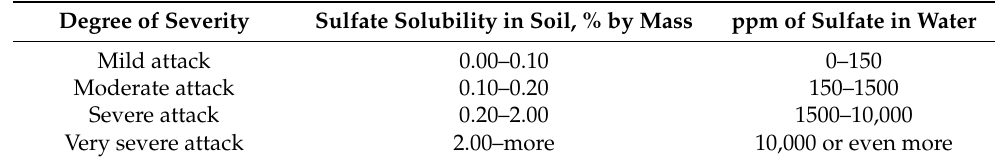
Table 1. Sulfate content severity (ACI-201-2008) [9]. Degree of Severity Sulfate Solubility in Soil, % by Mass ppm of Sulfate in Water Mild